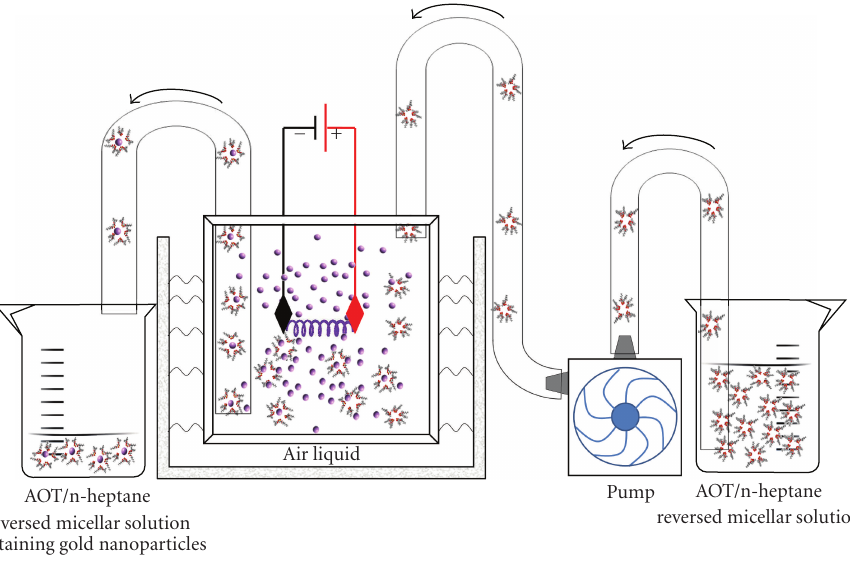
Air liquid AOT/n-heptane PumpAOT/n-heptane reversed micellar solution reversed micellar solution containing gold nanoparticles Heated gold filament Scheme 3: Schematic mechanism of the method proposed by Calandra et al. [33], based on the combined action of the Solvated Metal Atom Dispersion (SMAD) technique and the confinement in anhydrous reversed micellar